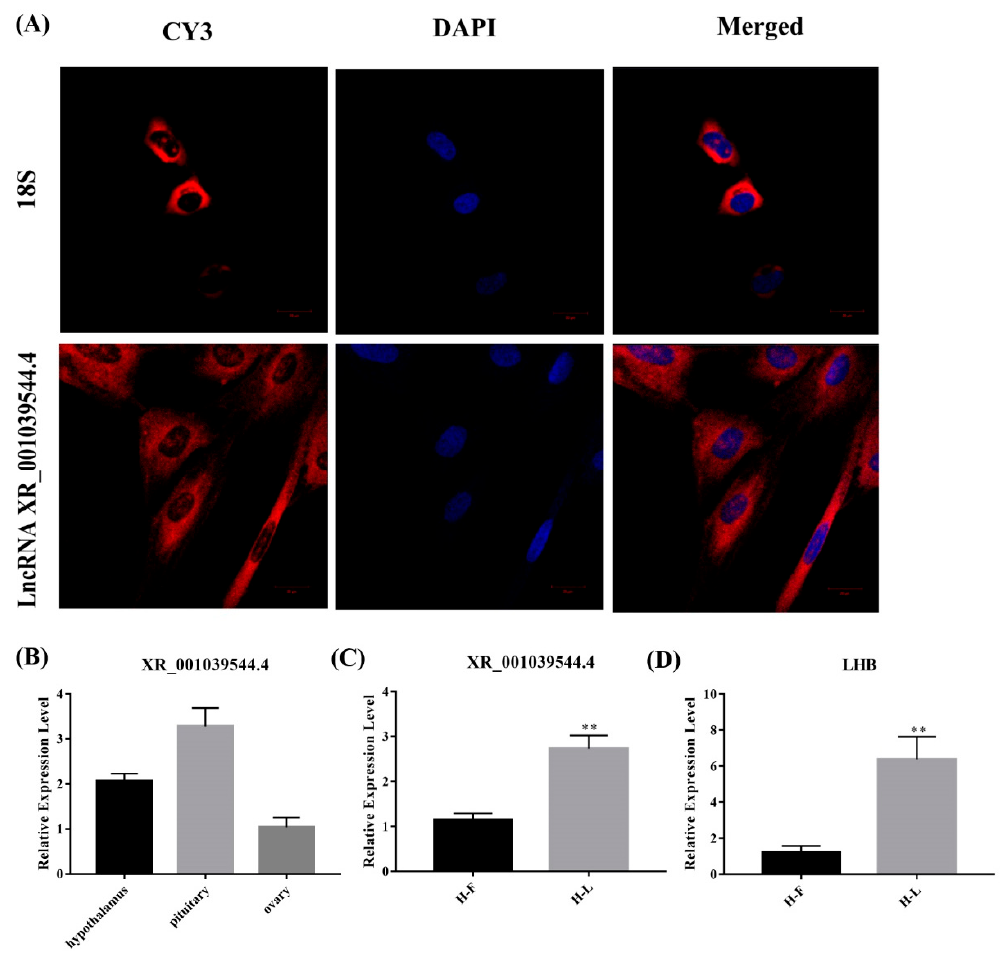
Figure 8. Identification of lncRNA XR_001039544.4. ( A ) lncRNA XR_001039544.4 localization in Hu sheep pituitary cells as detected by fluorescence in situ hybridization (FISH); scale bar, 20 μ m. ( B ) Expression of lncRNA XR_001039544.4 in the Hu sheep hypothalamus, ovary and pituitary gland (HPO axis). ( C and D ) Expression of lncRNA XR_001039544.4 and its target gene LHB in different stages of Hu sheep pituitary gland. The data are shown as the mean ± SEM of at least three independent experiments. Statistical significance was analyzed by one-way ANOVA and Student t-test ( ∗∗ p < 0.01).